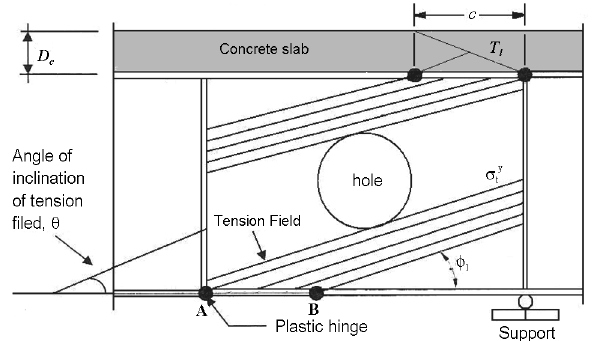
Fig. 6. Failure mechanism of girders with openings in the